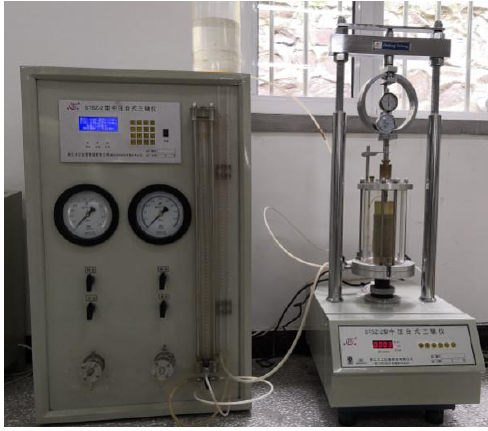
Figure 1. Triaxial test device.